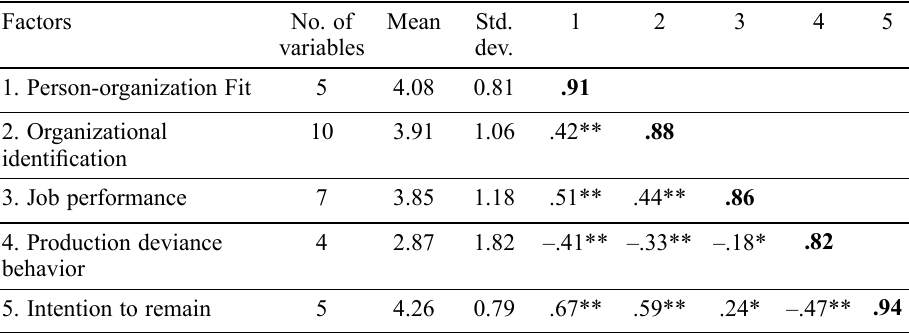
Table 1. Correlation analysis, mean and standard deviance Factors No.